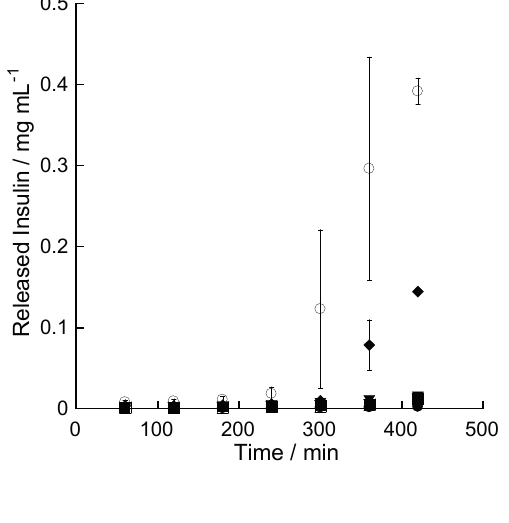
Figure 5. Amount of insulin released from (PAH/PSS) in buffer solutions at pH 7.4. The number of bilayers ( n ): 0 ( ○ ), 1 ( ◆ ), 3 ( ■ ), and 5 ( ● ). Average values of three measurements are